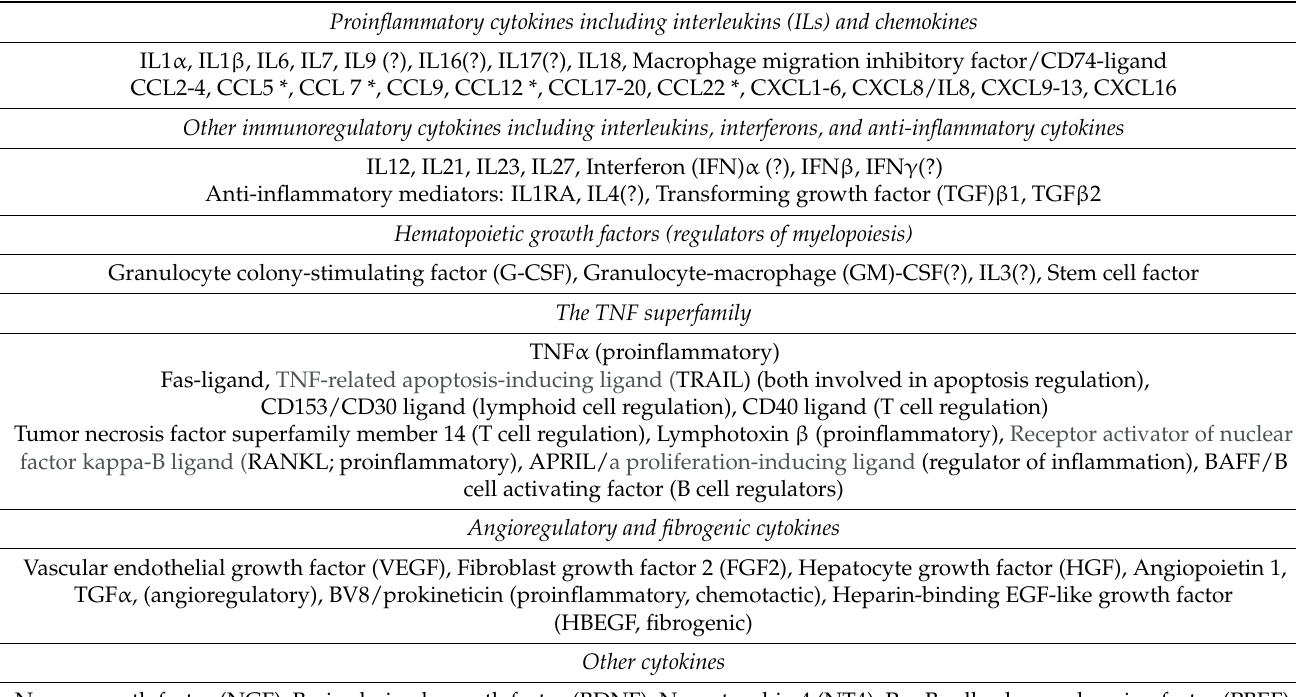
Table 1. Soluble mediators released by neutrophils [125–135]. For the TNF superfamily and angioreg- ulatory/fibroid and other cytokines groups we have indicated important functions in parentheses. Mediators studied mainly in animal models are marked *, and mediators where controversial data exist are marked with (?). Abbreviations: IFN, interferon, and TGF, transforming growth factor. Proinflammatory cytokines including interleukins (ILs) and